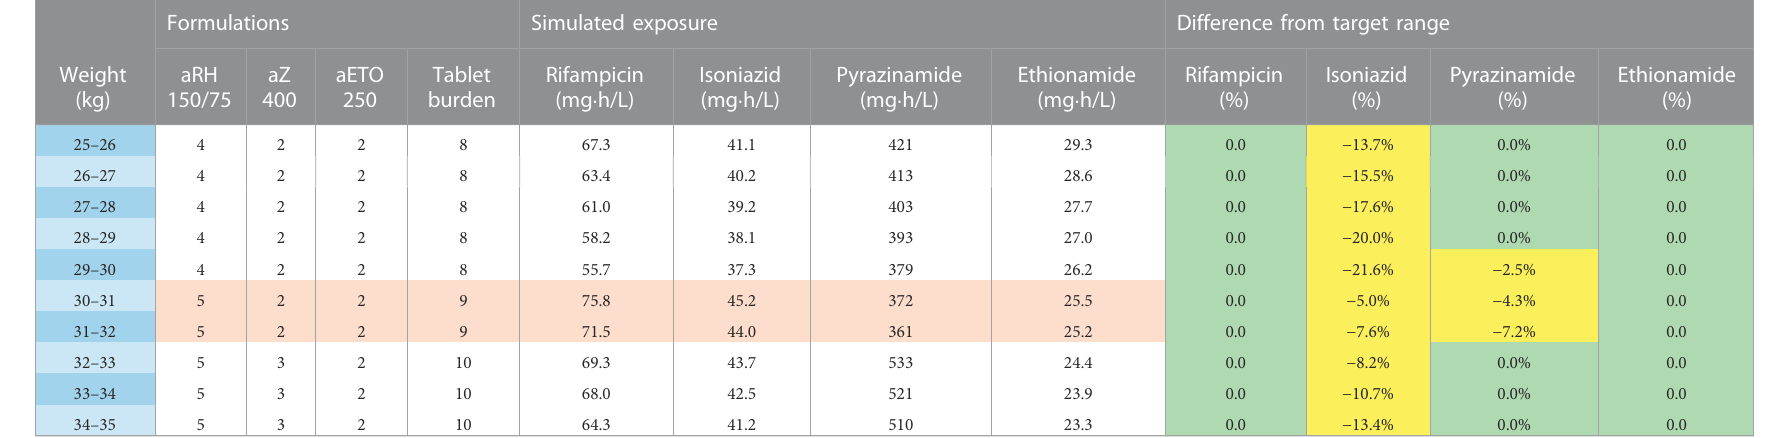
TABLE3Dosingtableusingadultformulationsforchildrenfrom25to35 kgandthe400 mgpyrazinamideformulation.Theredandwhitehorizontalbandsintheformulation ’ scolumnrepresenttheweightbandsreceivingthe same dose. The colours in the last columns show if exposures are expected to be within (green) or outside the target range where yellow represents the percentage below the lower bound of the target range and purple